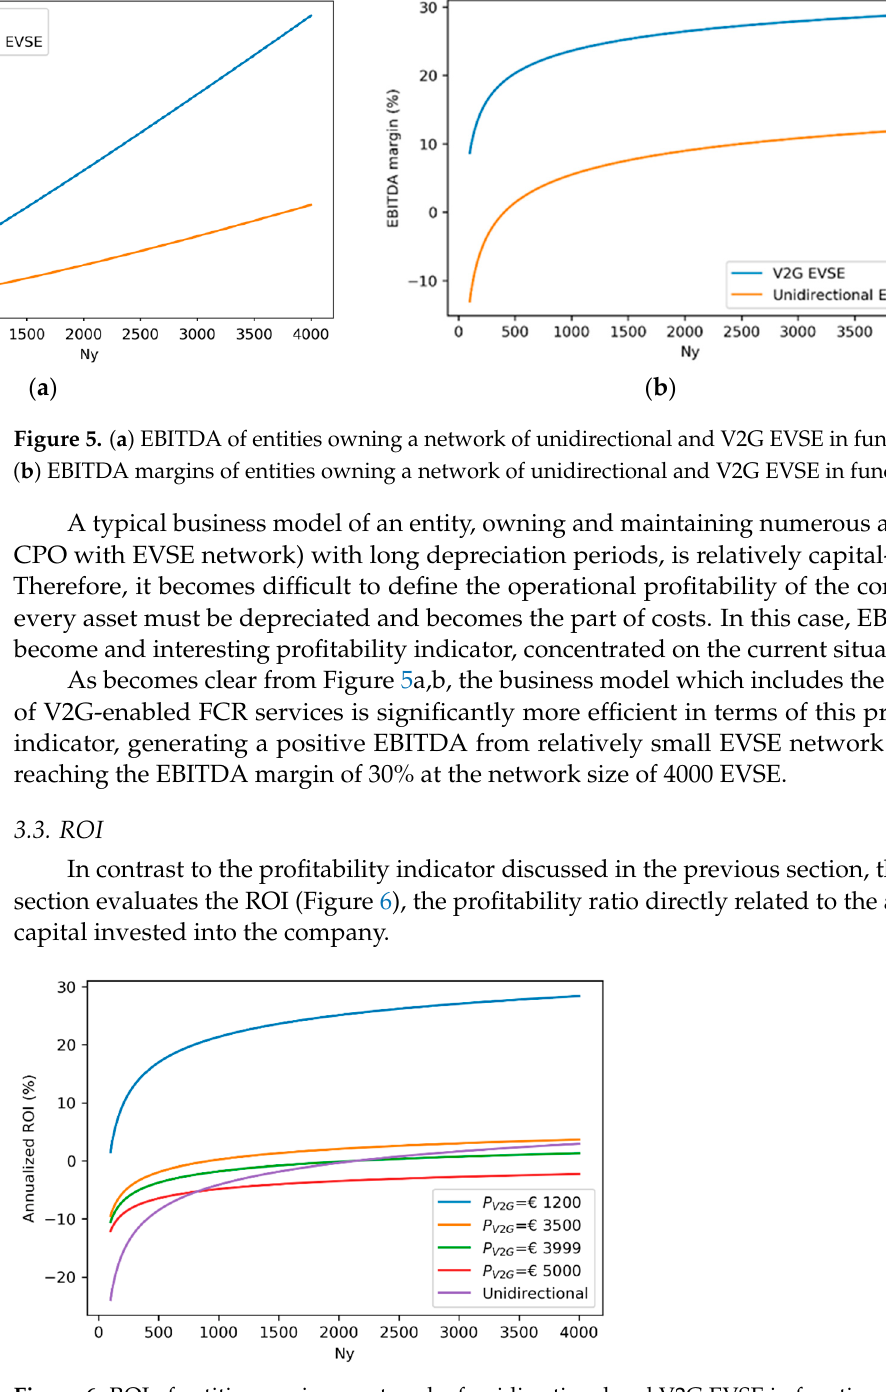
Entities owning EV charging infrastructure participate in a capital-intensive indus- try, having, in general, a relatively low EBIT margin (as described in Section 3.1). The combination of these two factors leads to a relatively low ROI, barely differentiating from zero, at the network size of 4000 EVSE. The obvious outlier with significantly higher ROI is the blue curve, indicating the V2G AC EVSE network with lower capital cost, creating high ROI of 30% within the network size of 4000 a relatively high ROI of 30% within the network size of 4000 EVSE.